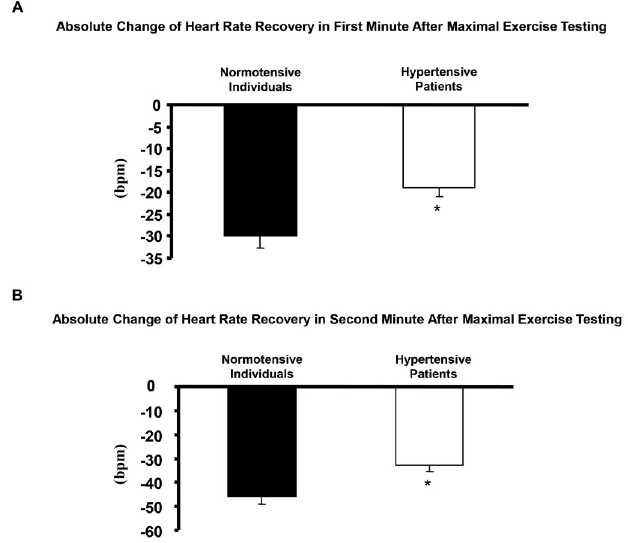
Figure 2. The decline rate of heart rate recovery (HRR) in first (Panel A) and second (Panel B) minutes after maximal exercise testing, in hypertensive patients and normotensive individuals. Note that the decline rate of HRR in first and second minutes after maximal exercise testing was significantly lower in hypertensive patients when compared with normotensive individuals. *= significant difference between groups,